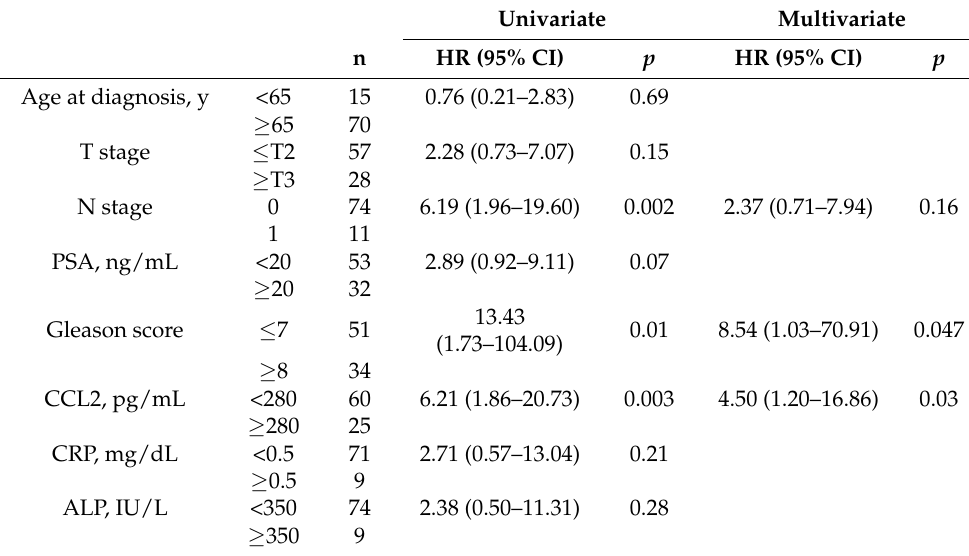
Table 3. Univariate and multivariate analyses of